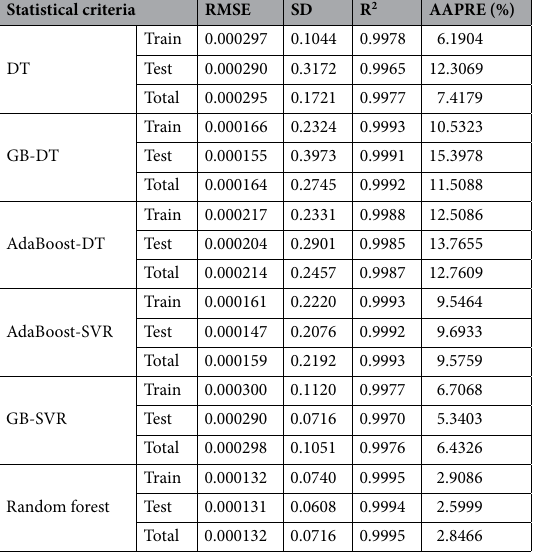
Table 5. Calculated statistical criteria for the proposed